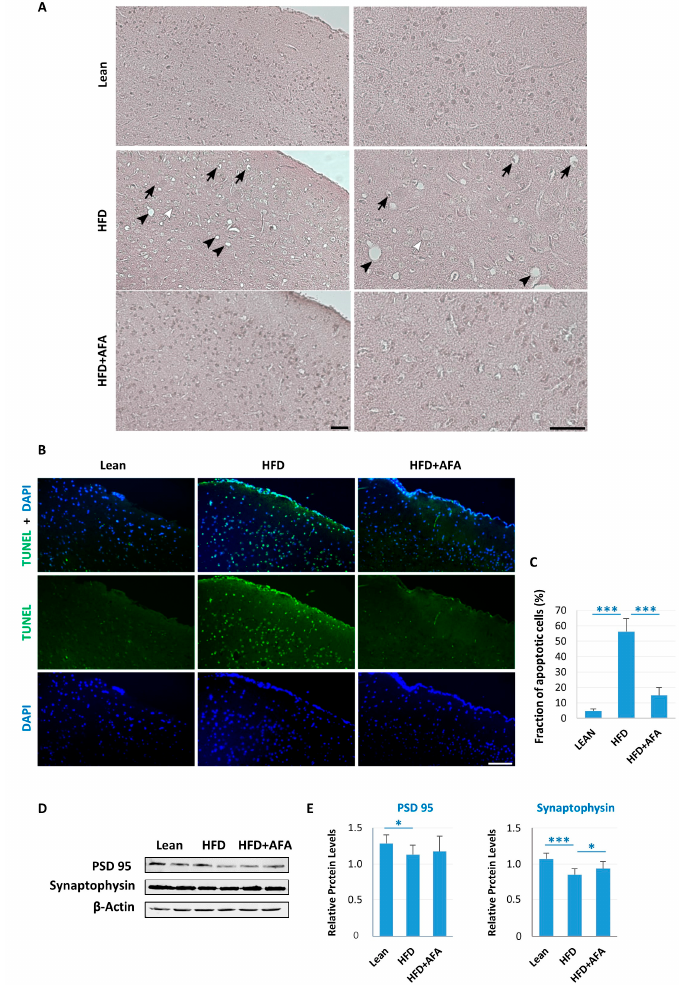
Figure 4. AFA ameliorates degeneration in the brain of diet-induced obese mice. ( A ) Morphology assessments on the cortex of Lean, HFD and HFD + AFA mice with hematoxylin and eosin stain. In the HFD group, there are numerous pycnotic (black arrows) and swollen (white arrows) cells, while strong vacuolation (arrowheads) was observed in all cortical layers. A sharp reduction in degenerative signs is observed in the sections of the AFA-treated group; ( B ) TUNEL assay on cerebral cortex sections; ( C ) Number of apoptotic nuclei in the cerebral cortex of Lean, HFD and HFD + AFA mice. Data are mean values ± S.E.M. (n = 6/group). *** p < 0.001. Scale bar, 50 µ m; ( D ) Western blot of protein extracted from brain lysates of different mouse groups and incubated with anti-PSD95, anti-synaptophysin, and anti- β -actin antibodies; and ( E ) Quantification of immunoblot was performed by using densitometric analysis; uniformity of gel loading was confirmed with β -actin utilized as standard. Results are shown as means ± SEM of 6 animals/group. * p < 0.05, *** p < 0.001 vs. indicated